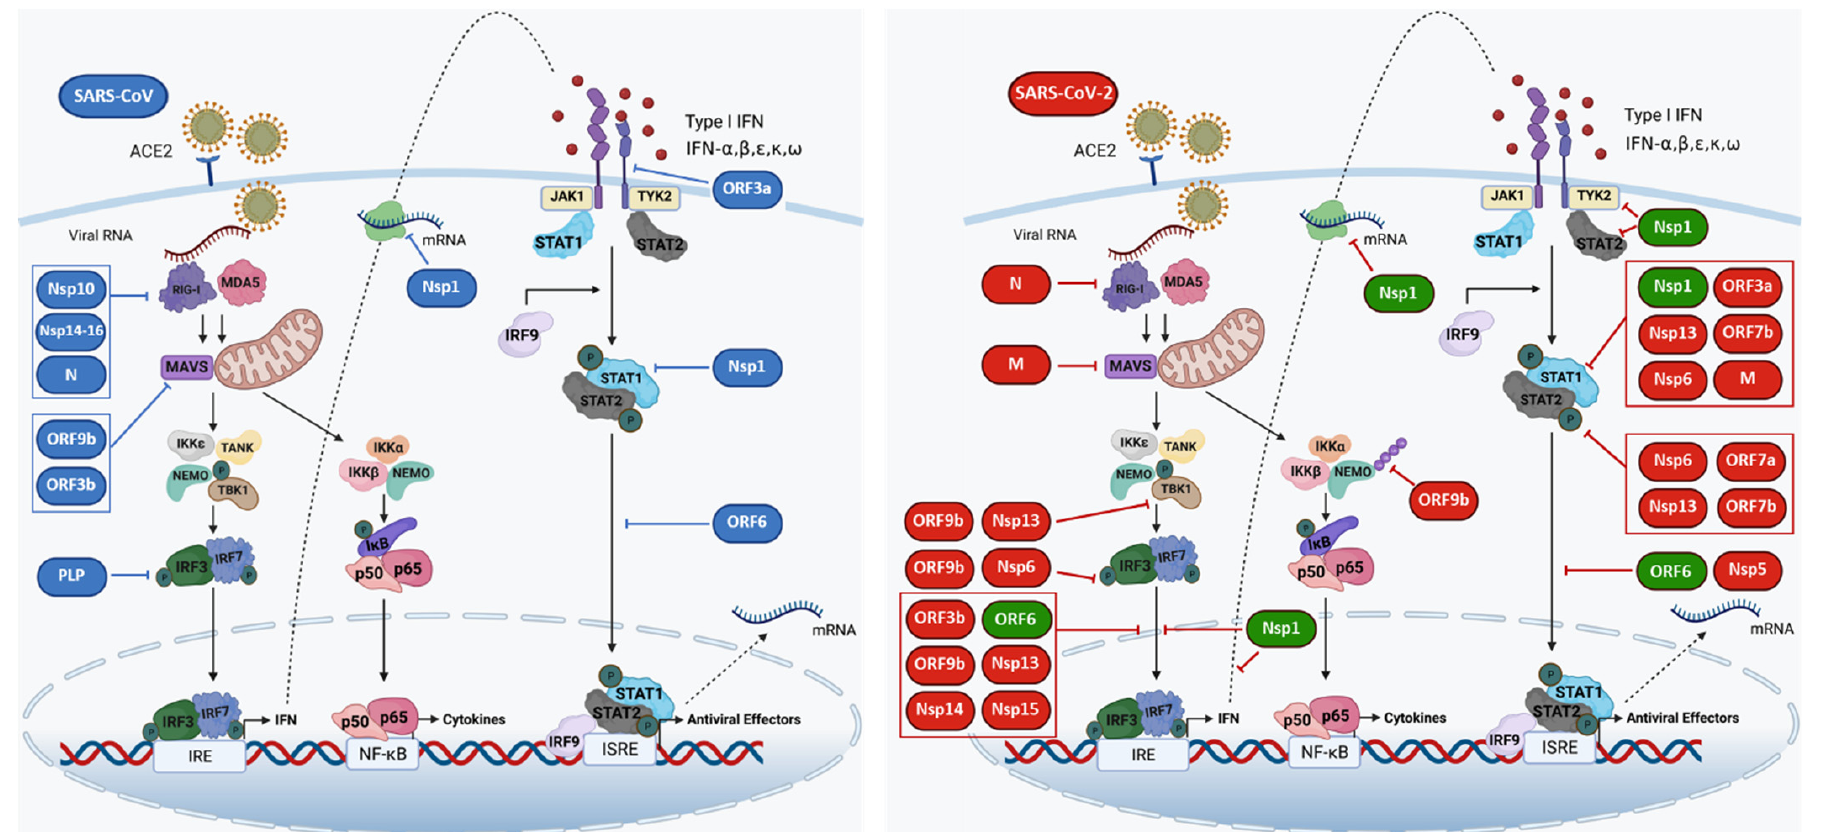
Figure 2. Schematic overview of type I IFN production and response and the counter measures due to the activity of several SARS-CoV-2 (red) and SARS-CoV (blue) proteins. These factors act at different steps in the signal transduction pathway, leading to inhibition of IFN-I production in the first stage and, subsequently, by inactivating the JAK–STAT–ISGF3 pathway, impairing ISGs transcription. ORF6 and Nsp1 represent the main inhibitors of IFN production and signaling (emphasized in green).